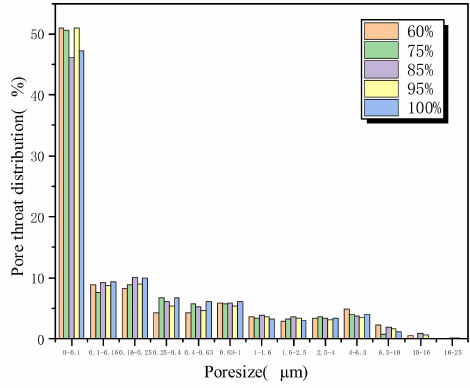
Figure 10. Pore size distribution.